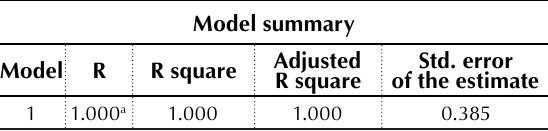
Table 1. Multiple regression model of the unadjusted EVA